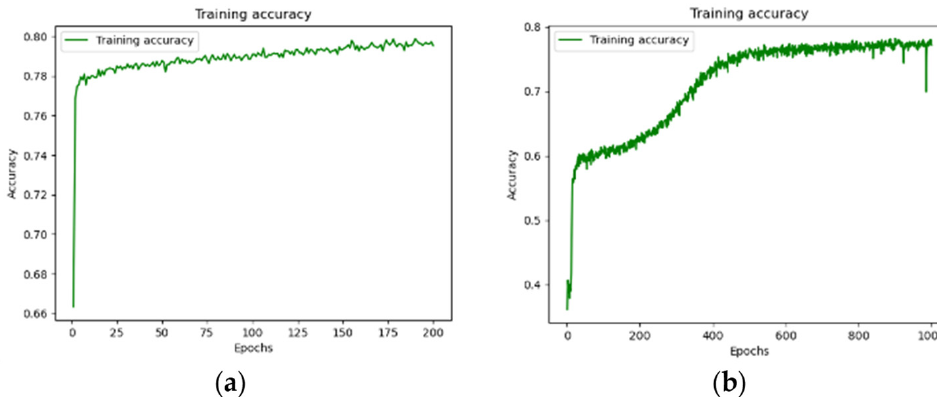
Figure 2. Training accuracy: ( a ) Model A and ( b ) Model B. The RF models produced 80.0% prediction accuracy for RF model A and 65% for RRF model B. Figure 3c,d present the confusion matrixes of the RF models. RF model A achieved 75% and 85% prediction accuracies for patients with a low and a high level of illness severity, respectively. RF Model B achieved a prediction accuracy of 92%, 33%, and 71% for patients diagnosed with COVID-19 with a low, medium, and high level of sever- ity, respectively.